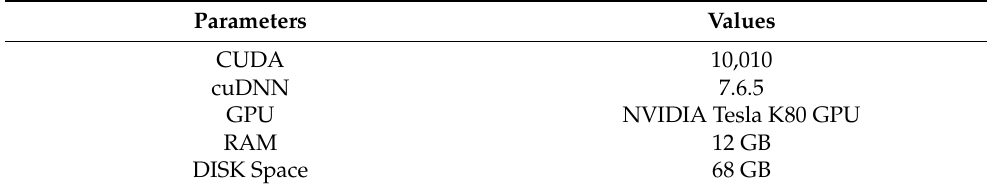
Table 4. Google Collab